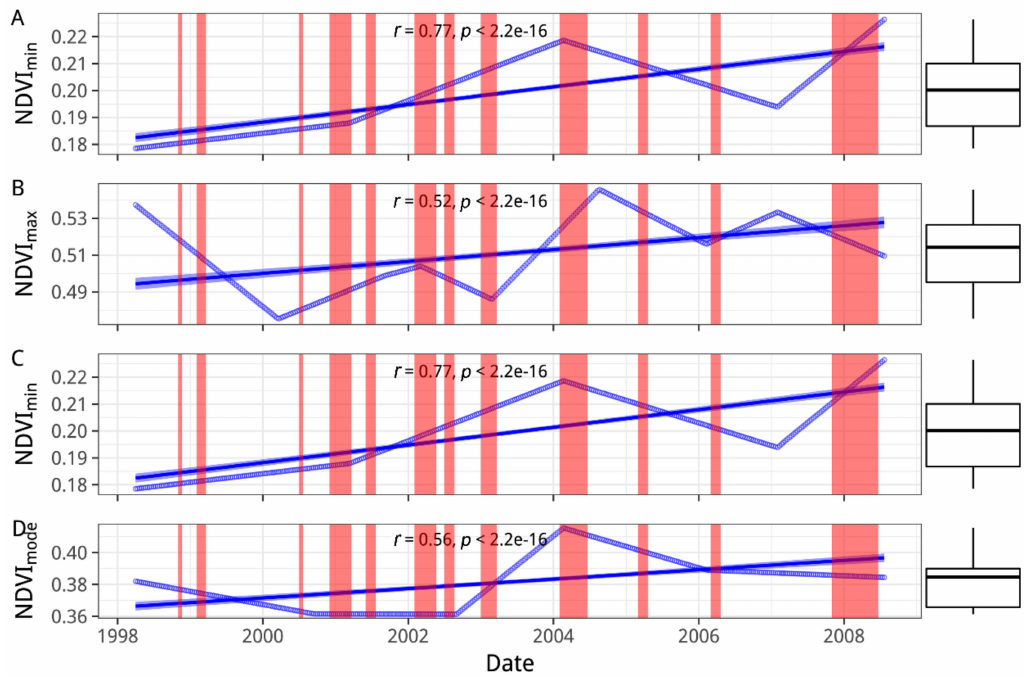
Figure 3. Linear fitness for the trend extracted from STR in ( A ) NDVI mean , ( B ) NDVI max , ( C ) NDVI min , and ( D ) NDVI most ; the color background represents the water allocation occupancy